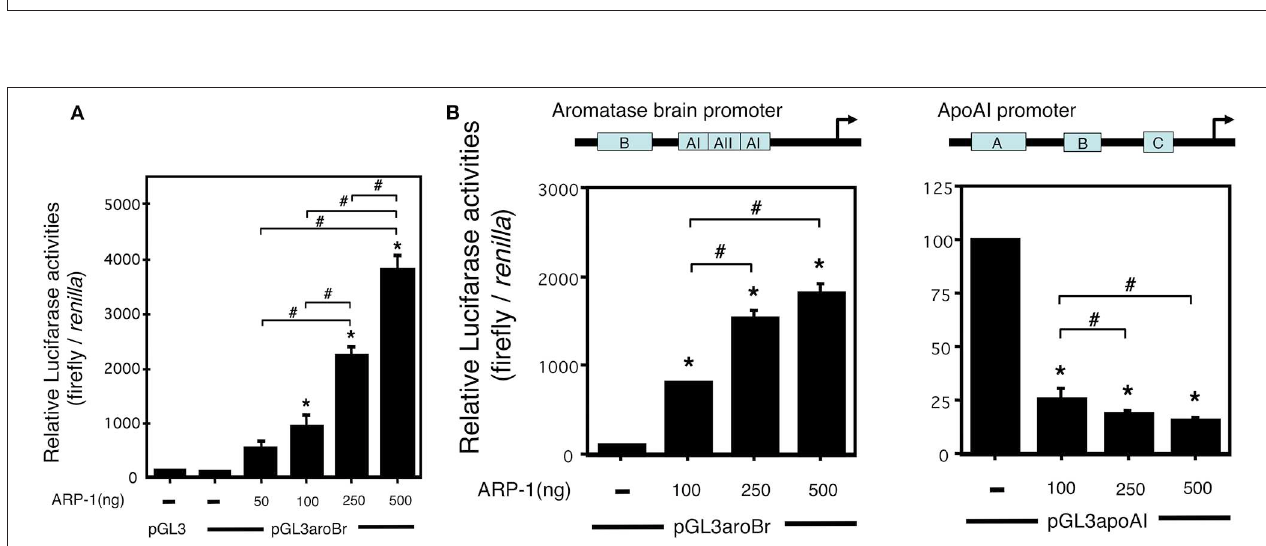
FIGURE 4 | ARP-1 increases brain-specific promoter activity of the mouse aromatase gene. (A) ARP-1 increases the promoter activity in a dose-dependent manner. The reporter plasmid (500 ng), pGL3aroBr, was co-transfected with the indicated amounts of pFLAG-ARP-1 plasmid (50, 100, 250, and 500 ng) and 50 ng of the internal control plasmid into CV-1 cells. The total amount of expression plasmid was adjusted to 500 ng with an empty plasmid (p3XFLAG-myc-CMV-26). The cells were harvested after 48h, and a Dual-Luciferase Reporter Assay was carried out as described in the Materials and Methods section. (B) Effects of ARP-1 on the activity of aromatase and apolipoprotein AI promoters in HepG2 cells. A Dual-Luciferase Reporter Assay was conducted as described in (A) . The mean ± SEM of at least three independent experiments is shown in the figure. One-way ANOVA showed a significantly different distribution ( p < 0.0001 for (A,B) . The p -value of the Tukey–Kramer test is indicated with the symbols as follows. Asterisks indicate statistically significant differences in relative promoter activity between the empty plasmid alone and that after co-transfection with the ARP-1 expression plasmid ( p < 0.05). Pound signs indicate statistically significant differences in comparisons between indicated pairs ( p <